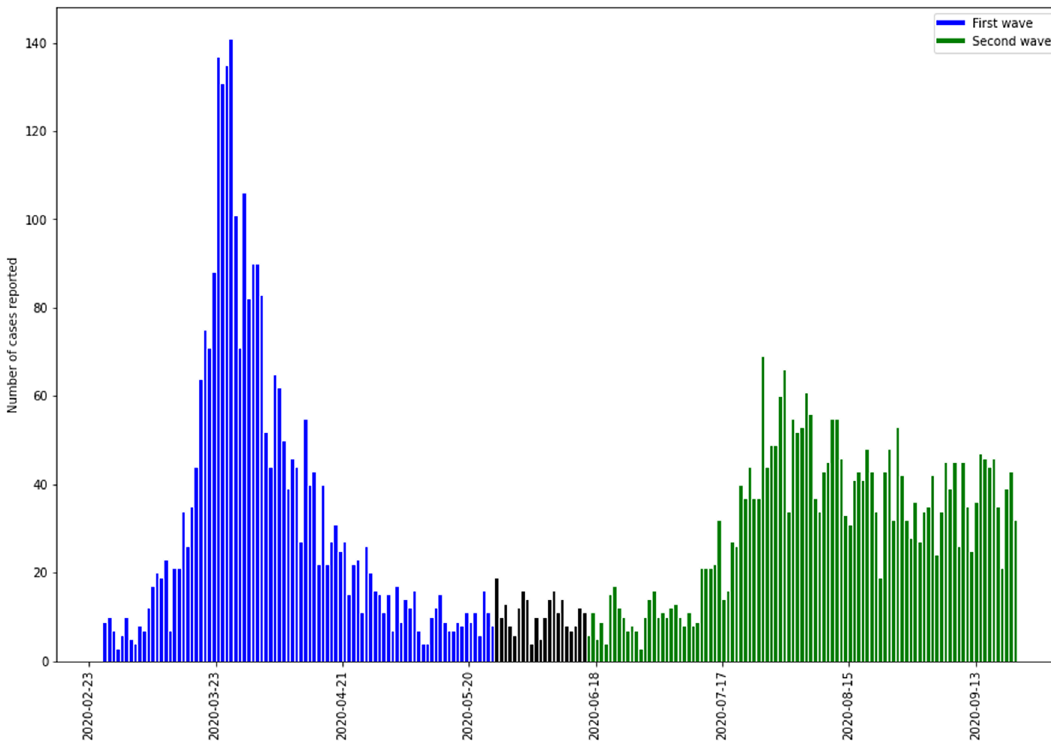
Figure 1. Hospitalized patients with positive SARS-Co V-2 RT-PCR test results in both pandemic waves in Aragon, Spain, February-September 2020. Blue : first wave; green : second